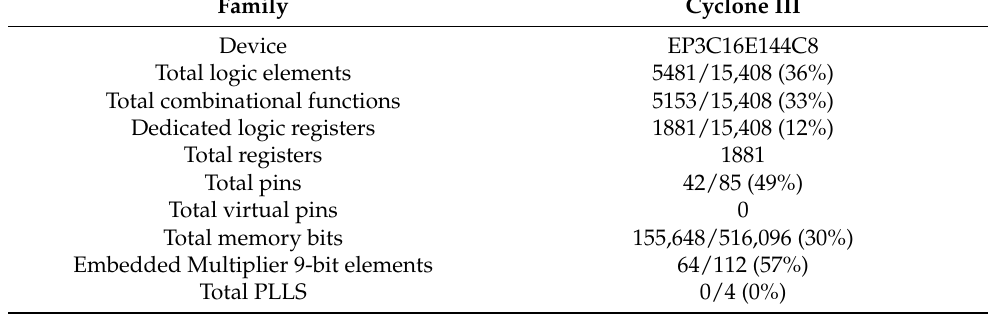
Table 2. The usage of chip to realize the drive system.